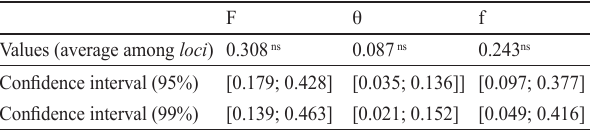
Tab. 3. Inbreeding rates of Weir and Cockerham (1984) with confidence intervals for the Bootstrap averages (ns = non significant).